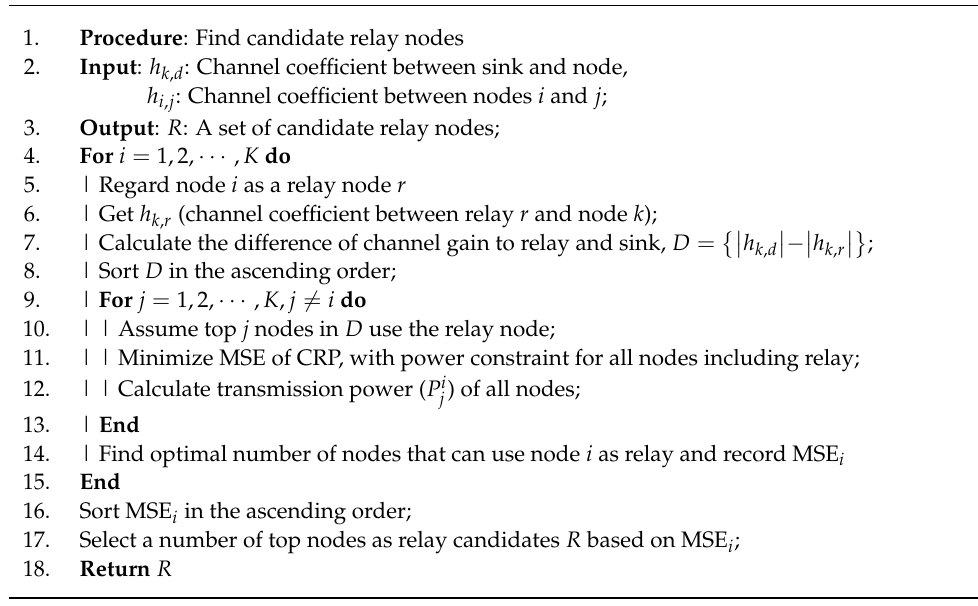
Algorithm 1: Select candidate relay